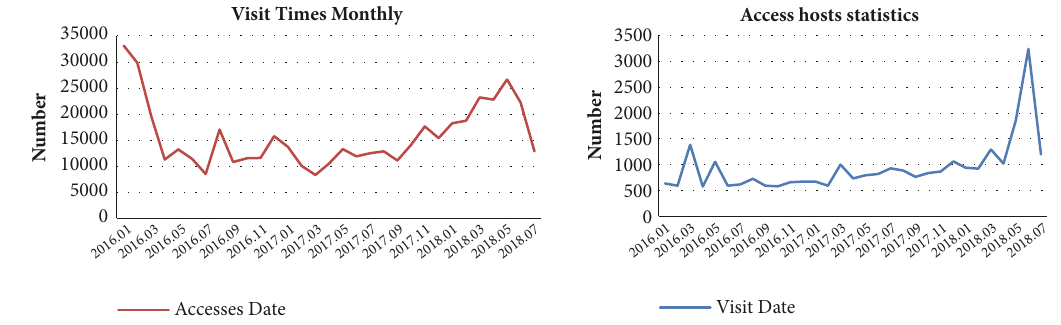
Figure 8: NSRT pulsar data service accessing